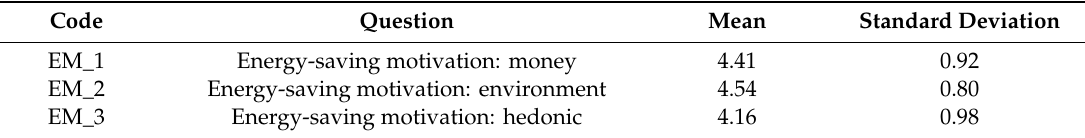
Table 9. Mean for energy-saving motivation (very unimportant (1) to very important (5)). Code